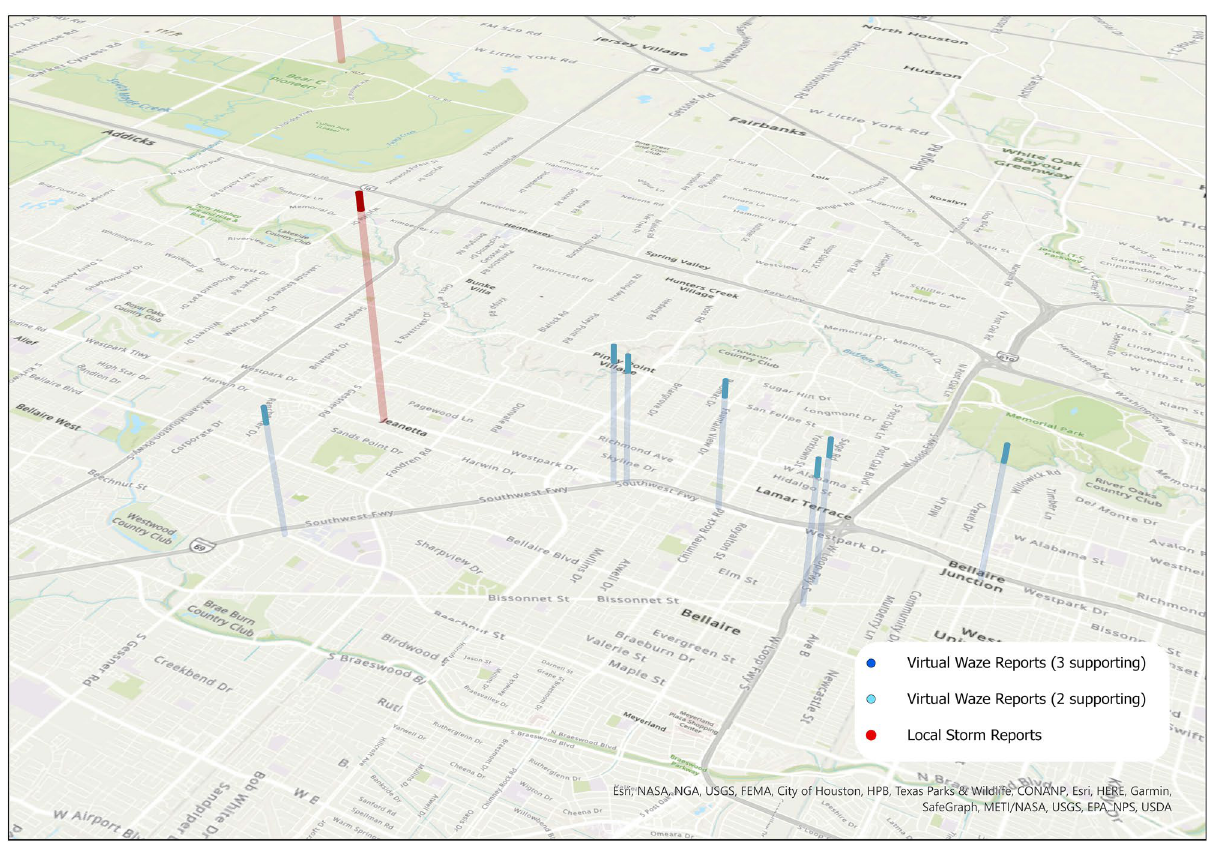
Figure 6. VWRs reported flooding west of Houston, notably earlier than existing LSRs. The height of the bars represents time, with a difference of about 6.5 h between the VWRs (blue) and the LSR (red). In this example, VWRs appeared in the evening of the 26th, while the LSR was issued on the morning of the 27th. Map created using ArcGIS Pro 71